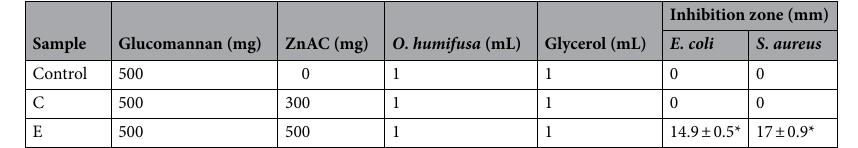
Table 2. Antimicrobial inhibition zone of hand gels. * The statistical analysis was performed using ANOVA (N = 3), p-value less than 0.05 is considered as statistically significant, *p < 0.05.